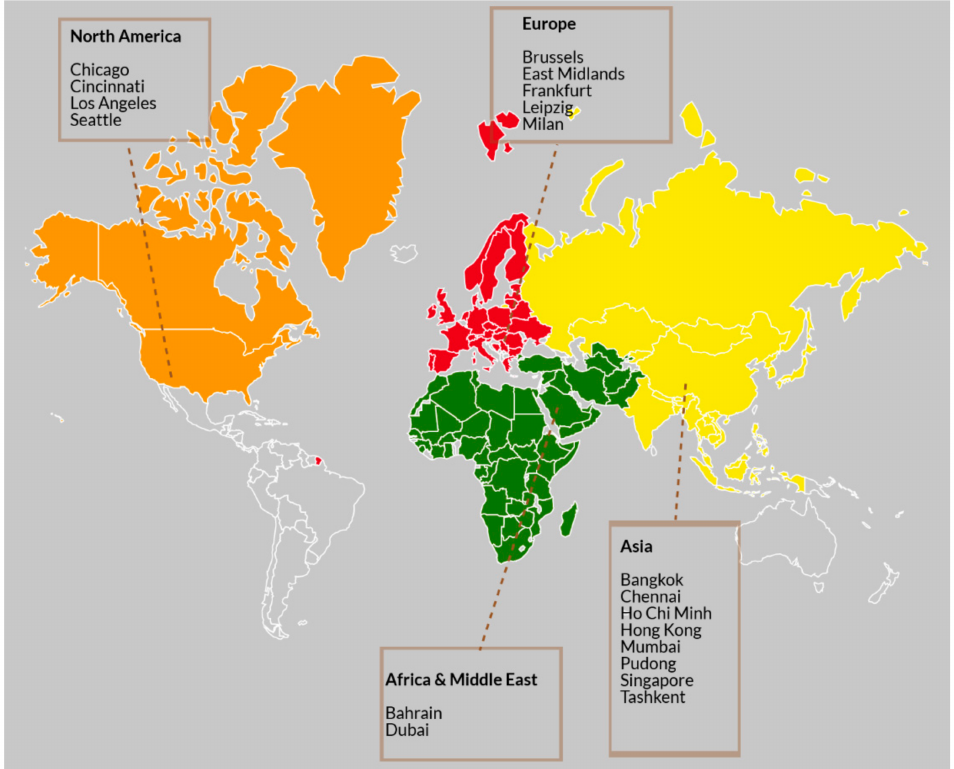
Figure 4. The AeroLogic route network: 2017. Airports Legend: BAH–Bahrain;